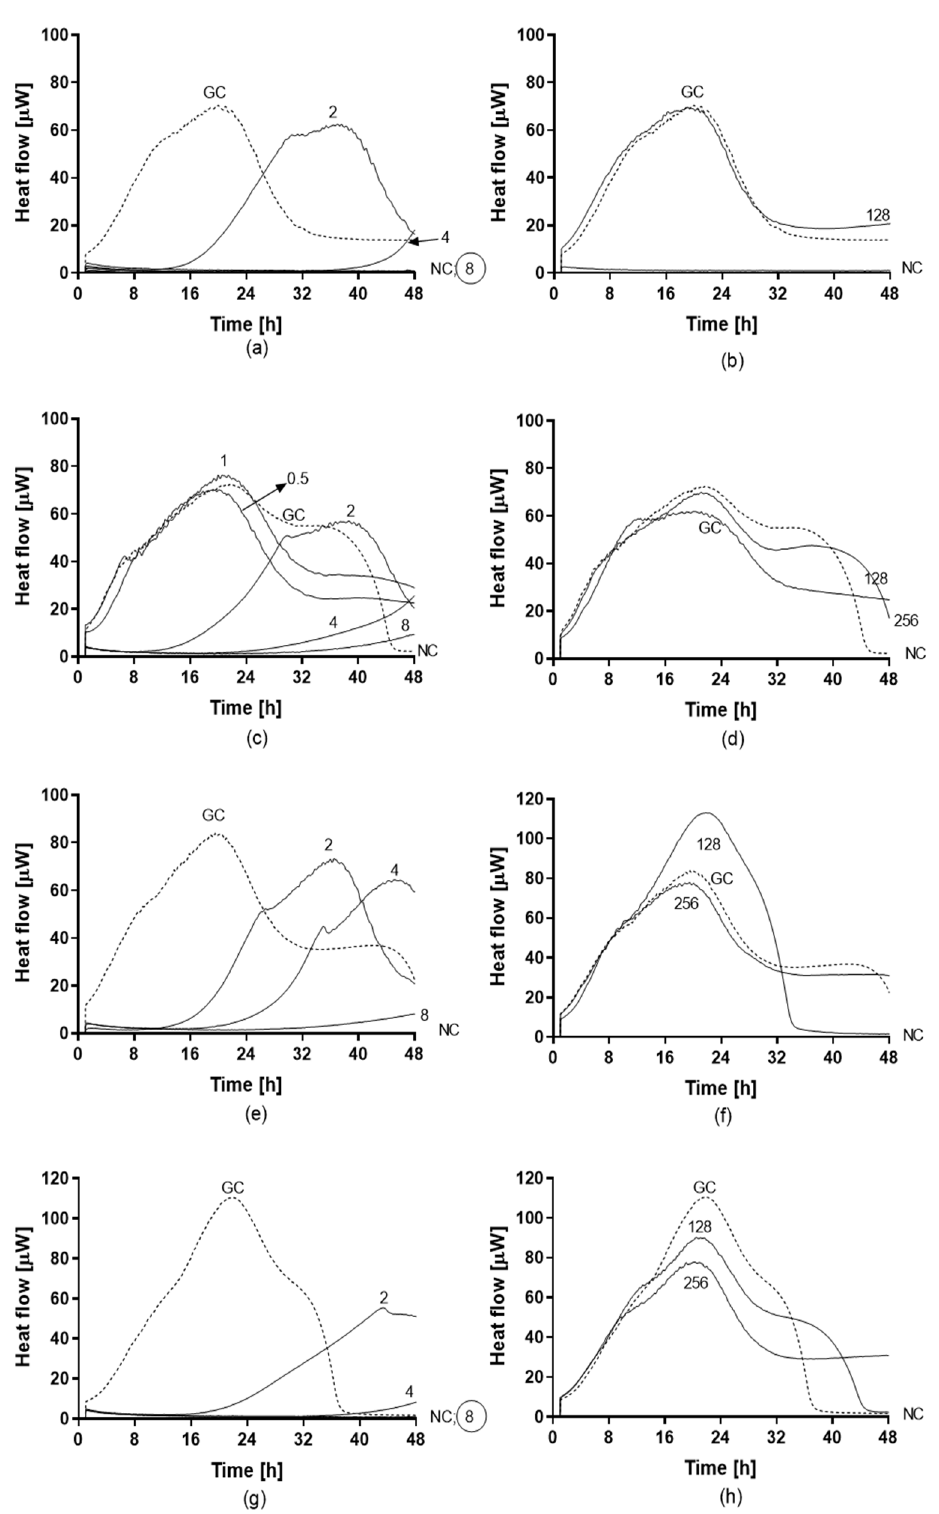
Figure 6. Heat flow curves generated by biofilm-embedded yeasts of C. auris 10051257 ( a , b ), C. auris 10051259 ( c , d ), C. auris 10051266 ( e , f ), and C. auris 10051297 ( g , h ) after treatment with different concentrations of amphotericin B ( a , c , e , g ) and fluconazole ( b , d , f , h ). Numbers indicate the antifungal concentrations (µg/mL). GC: growth control (without any antifungal treatment). The minimum biofilm fungicidal concentration (MBFC) was defined as the lowest antifungal concentration which led to undetectable heat flow values. The circled value denotes the minimum biofilm eradicating concentration (MBEC).